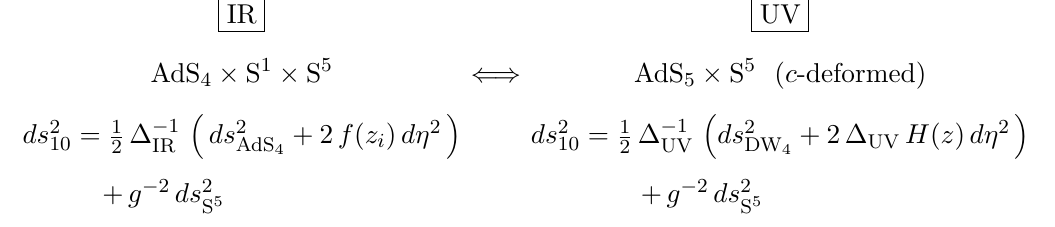
Figure 12 . Type IIB geometry describing an holographic RG flows across dimensions from ( c - dependent deformations of) N = 4 SYM